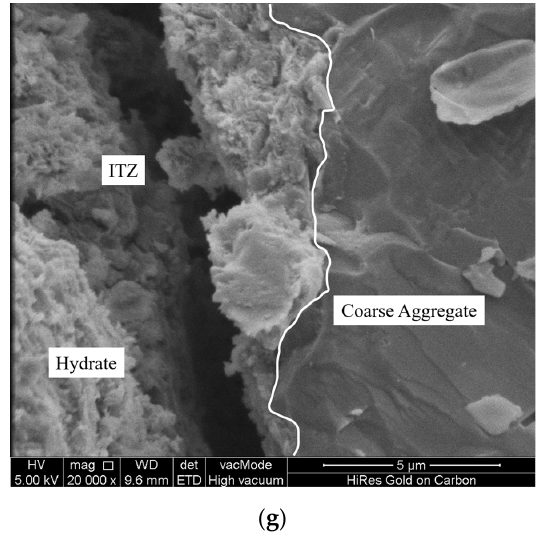
Figure 9. Micromorphology of interfacial transition zone of recycled aggregate concrete treated by different strengthening methods: ( a ) R0; ( b ) S1; ( c ) S2; ( d ) P1; ( e ) S1S2; ( f ) S1P1; and ( g ) S2P1.